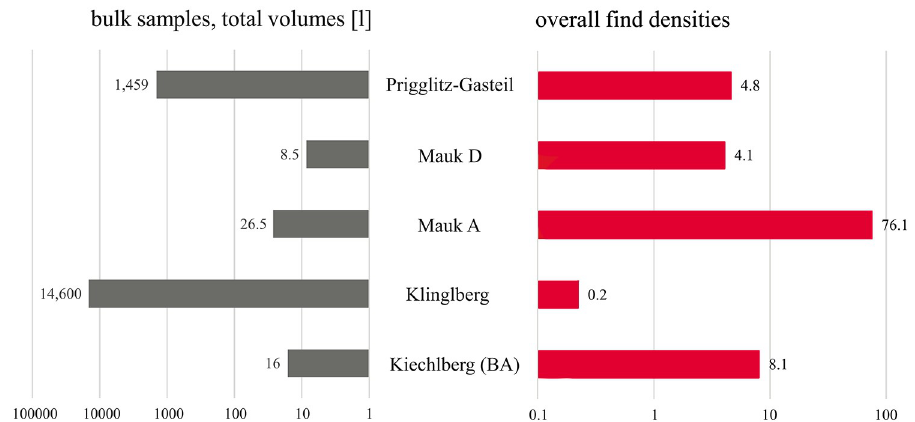
Fig 17. Overview of the sediment samples from the sites discussed in this paper. Left side: total sample volumes, right side: resulting find densities. Both horizontal axes are in logarithmic scale due to the differences in magnitudes. Top: younger sites, bottom: older sites. Find numbers of conifer needles from Mauken were adapted to the counting method described in section 2.3.3. For Mauk A, no figures of unidentified plant remains were available [6], thus lowering the overall find density for the site. Illustration: OeAW-OeAI/A. G. Heiss.